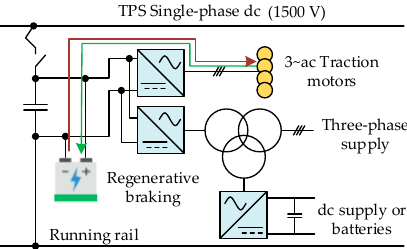
Figure 32. Traction power supply system configuration with regenerative braking: Ac overhead catenary line.